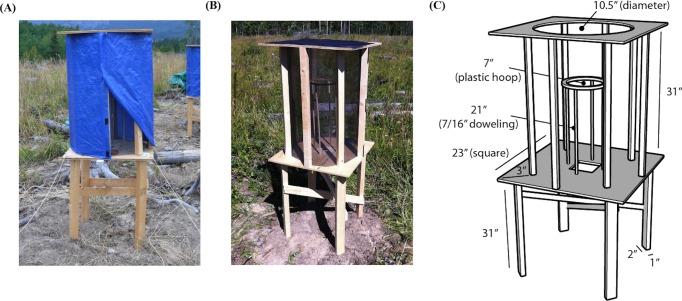
Holding and orientation cages as modified from Fitzgerald & Taylor (2008).(A) Orientation cage with tarp shield. (B) Orientation cage without tarp shield. (C) Dimensions.